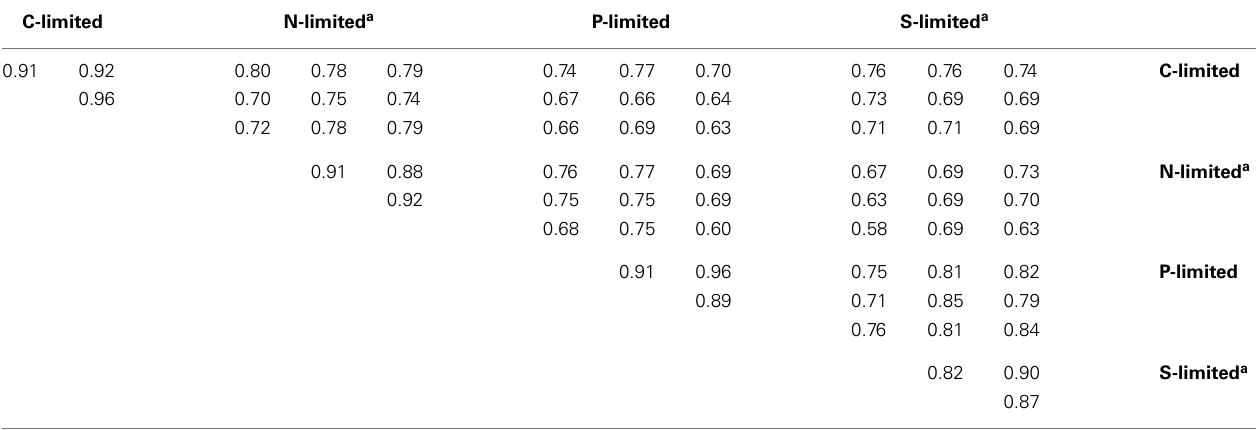
TableA2 | Spearman’s rank correlation coefficients of the normalized fluorescence values in 5,145 probes between replicate